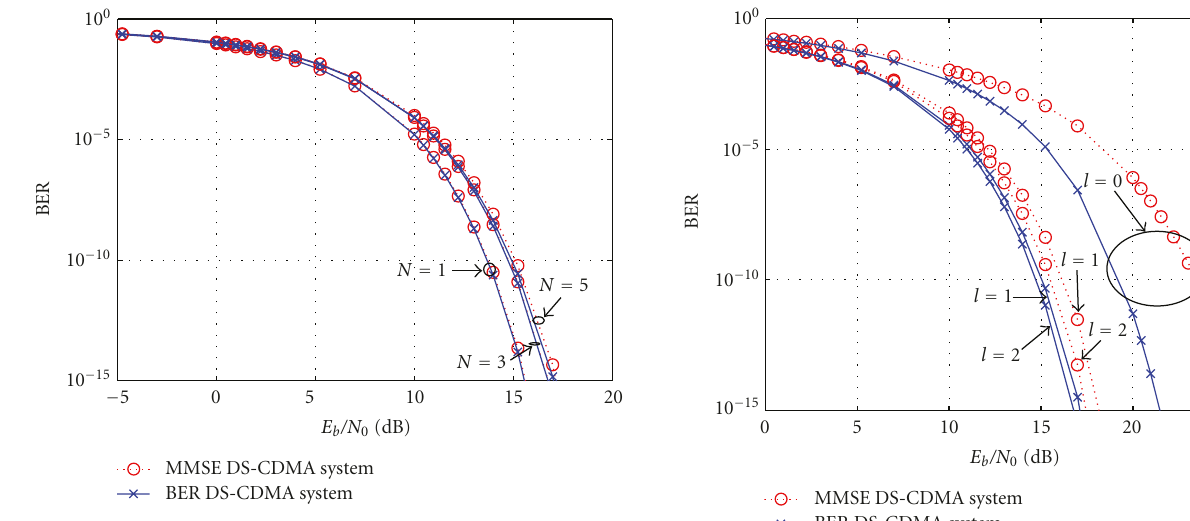
Figure 4: BER versus E b / N 0 performances of the MMSE DS- CDMA system ( ··· ◦ ··· ) and the proposed minimum BER DS- CDMA system ( − × − ) for di ff erent number of users N ∈ { 1,3,5 } , when M = 7, L = 5, and l = 0. When N increases, then the performance curves move upward.